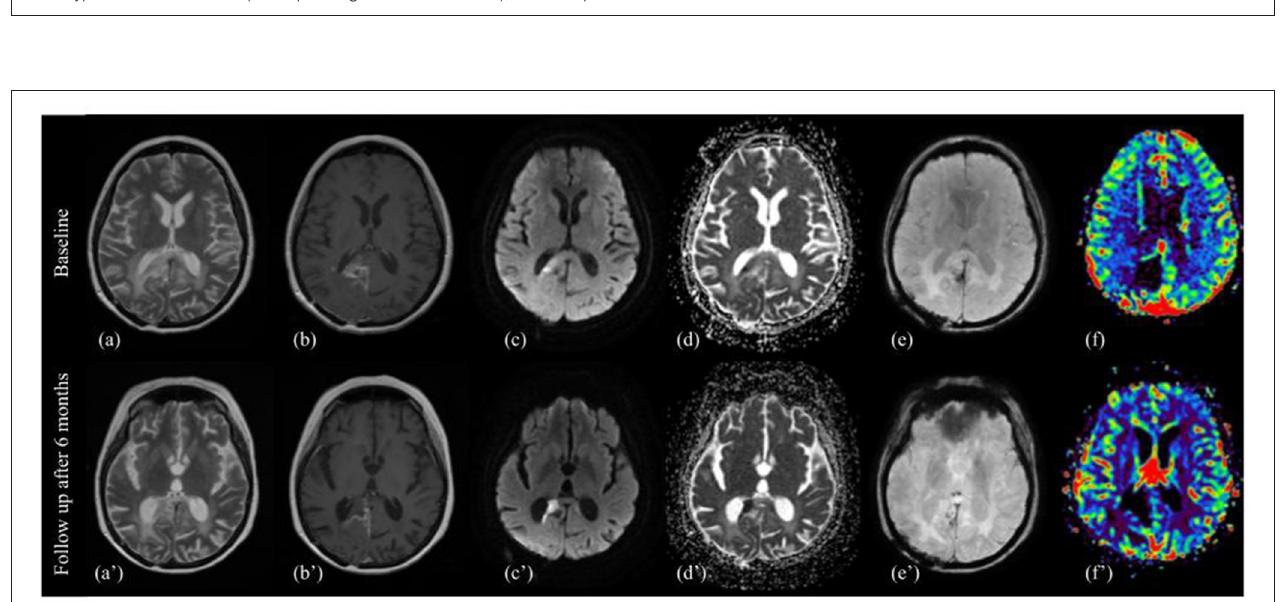
FIGURE 2 | Pattern B. MRI changes in recurrent high grade glioma under regorafenib, pattern B. MRI scans performed at baseline (top image) and after six months (bottom image) from the first administration of REG therapy. T2w images (a,a’) , contrast enhanced T1w images (b,b’) , diffusion-weighted b1000 (c,c’) , apparent diffusion coefficients (ADC) map (d,d’) , SWI images (e,e’) , and color-coded perfusion map (f,f’) are shown from left to right. On 6-month follow-up MRI, the previously enhanced tumor component showed a dramatically absence of CE, diffusion restriction on DWI and ADC map, and decrease signal on corresponding T2 image, surrounding by a thin hypointense rim on SWI, and peripheral contrast enhancement on T1-wi after gadolinium. There was also a decrease of peritumoral edema.